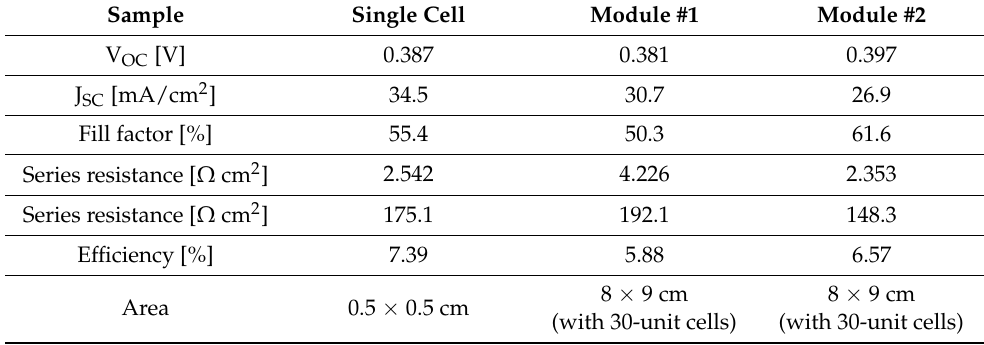
Figure 6. Illuminated I–V characteristics of an MOCVD-prepared CIS solar cell under standard test conditions (STC, 100 mW cm − 2 ). ( a ) J–V characteristics of a cell and calculated J–V characteristics of sub-modules #1 and #2. ( b ) I–V characteristics of sub-modules #1 and #2. Table 2. Photovoltaic performance of an MOCVD-prepared CIS solar cell and sub-modules.